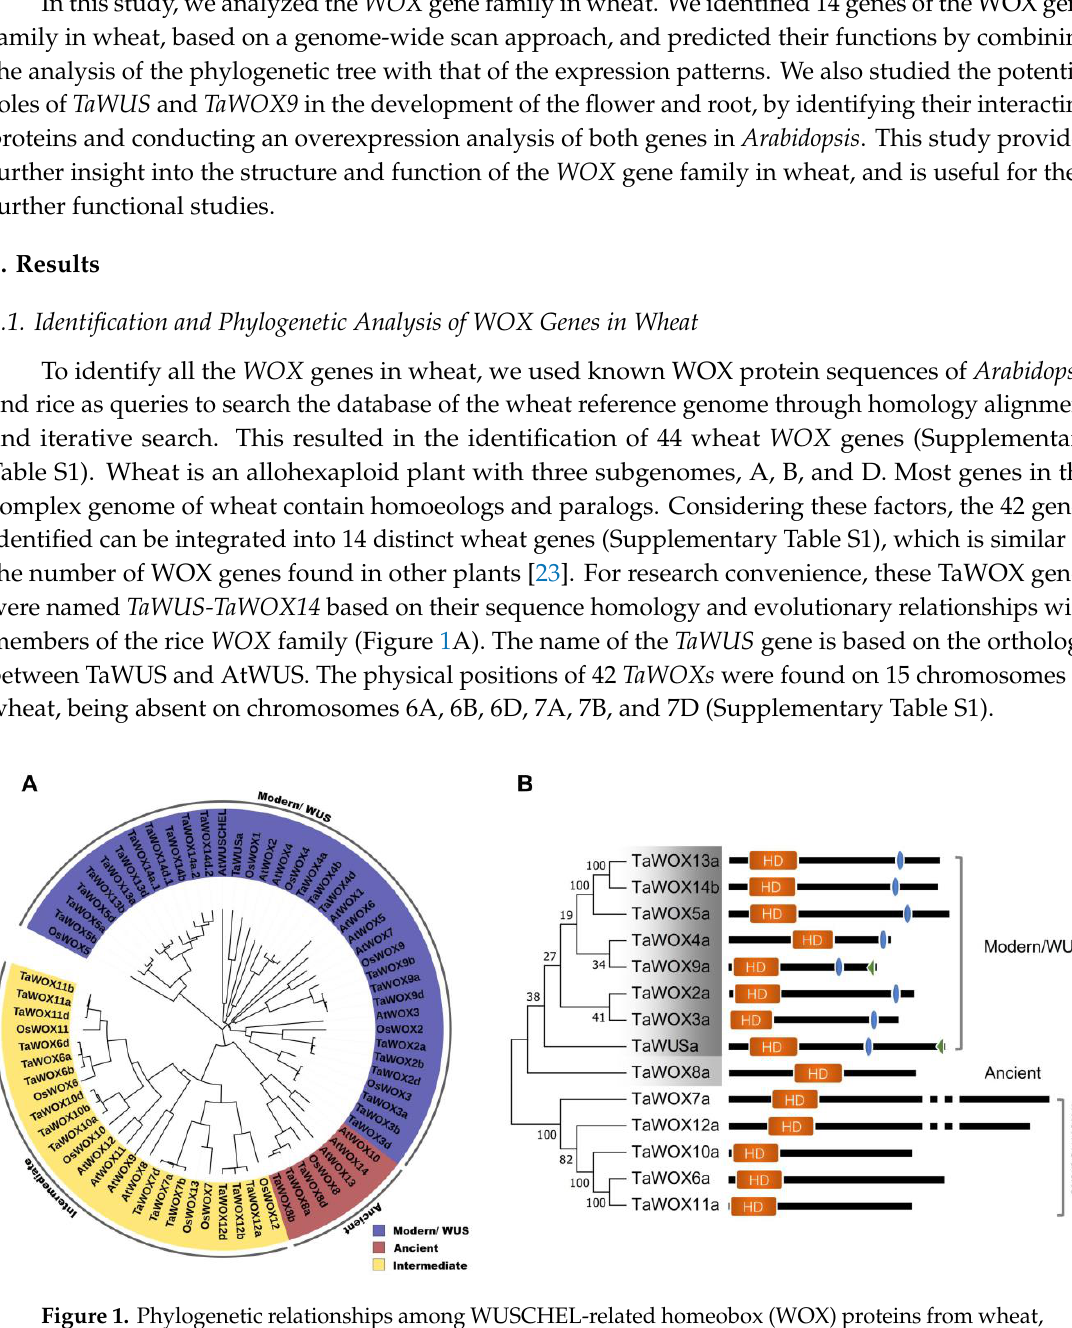
Figure 1. Phylogenetic relationships among WUSCHEL-related homeobox (WOX) proteins from wheat, rice, and Arabidopsis , and analysis of TaWOX protein domain arrangement. ( A ) Phylogenetic analysis was performed using the multiple sequence alignment generated with entire WOX protein sequences. ( B ) Depiction of the domain structure of each TaWOX protein sequence. Orange rectangles represent the homeodomain (HD). The steel blue rectangles represent the WUSCHEL (WUS)-box motif. The green triangles represent the ERF-associated amphiphilic repression (EAR)-like motif.